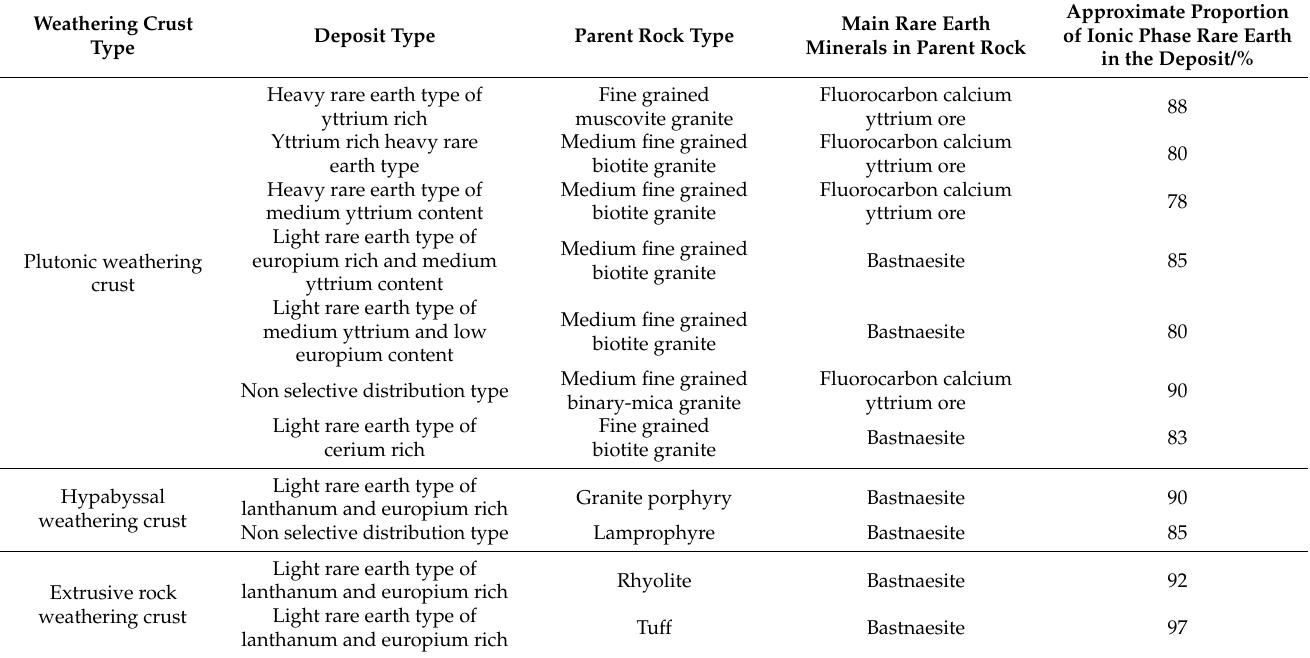
Table 2. Classification of ionic rare earth deposits in